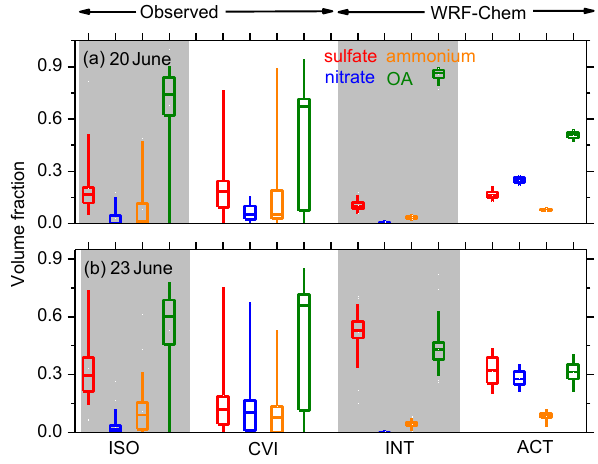
Figure 12. Similar to Fig. 11 but only for aerosol volume fraction on 20 (a) and 23 (b) June 2007. WRF-Chem results are only for cases in which the aqueous chemistry is turned